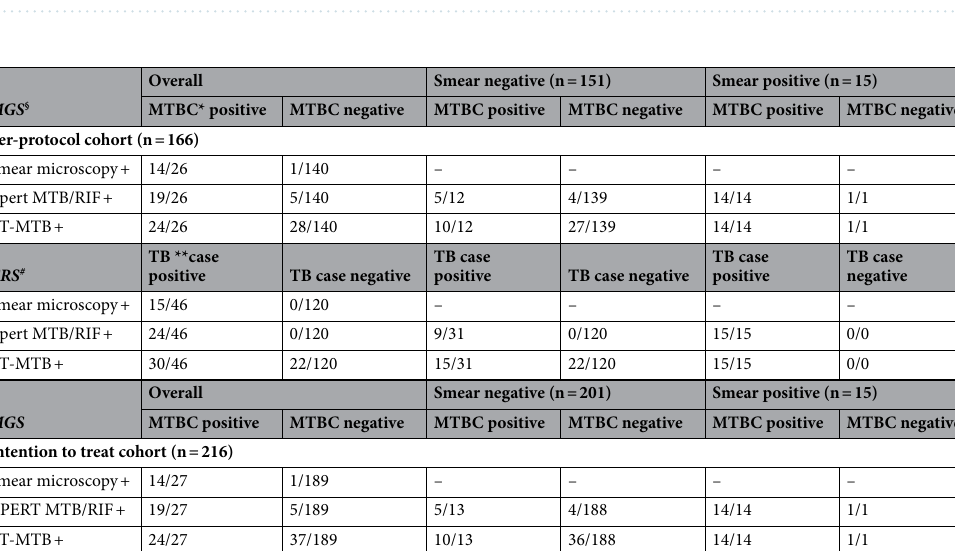
Table 1. Per-protocol cohort. Characteristics of individuals included in the analysis (n = 216). Figures have been calculated based on the total number of participants with baseline visit (n = 216) 1 IQR interquartile range; 2 ART antiretroviral therapy. 3 3 missing values for viral load results; 4 The limit of detection for the Abbott Realtime HIV-1 assay was 150 copies/ml.